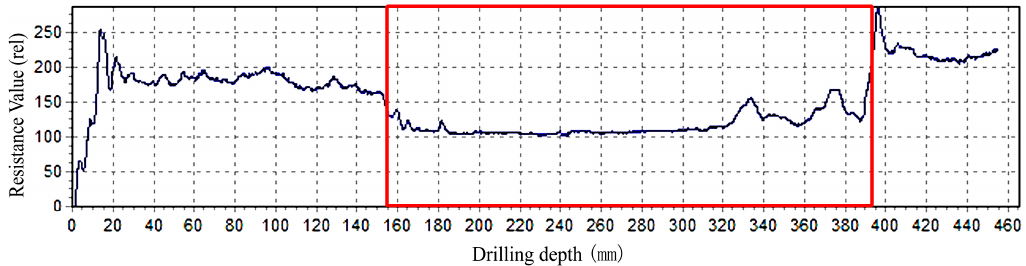
Figure 6. Example of the impedance of internal defects in column C5 Note: Represents the position and length of defects in the path under relative resistance.